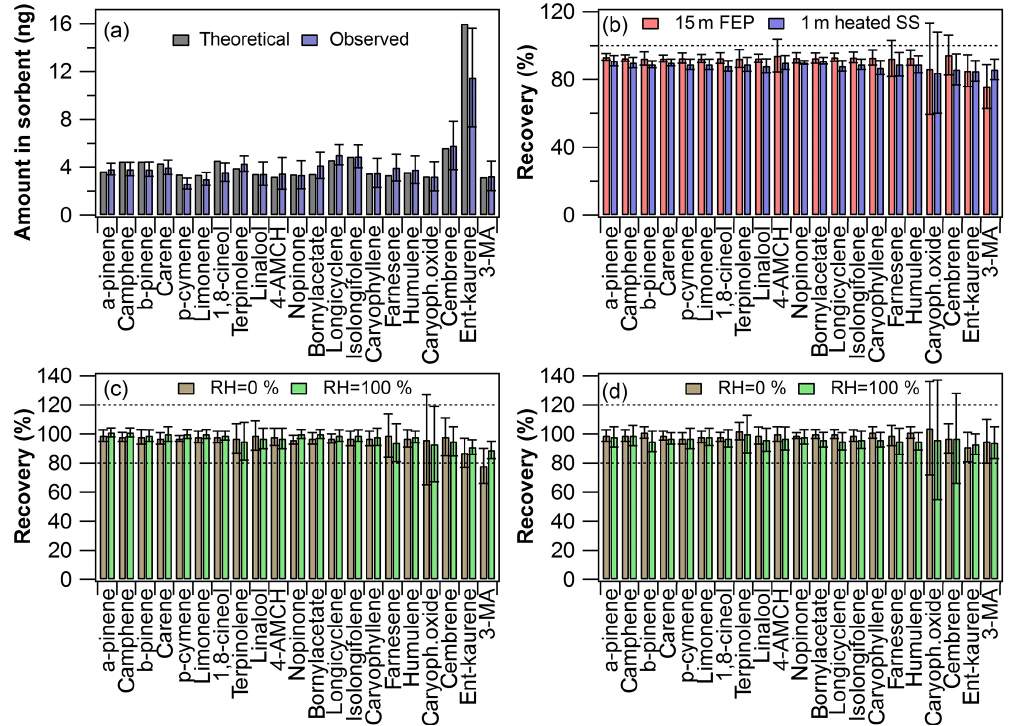
Figure 2. Inlet recovery experiment results: (a) calculated theoretical amount and observed amount in the first sorbent tube ( n = 18); (b) inlet recovery levels at laboratory room conditions ( n = 9 with both inlets); (c) inlet recovery levels at different RH levels with the Teflon FEP inlet ( n = 8–10) and (d) with the heated stainless-steel inlet ( n = 9–10). The error bars represent reproducibility ( n =